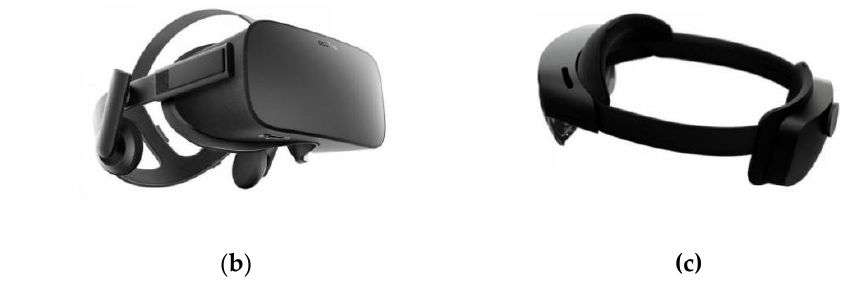
Figure 9. VR/AR devices: ( a ) HTC Vive [140]; ( b ) Oculus Rift [141]; ( c ) HoloLens 2 [142].